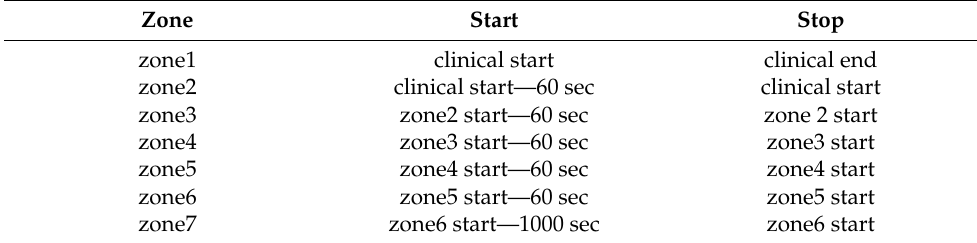
Zone Start Stop zone1 clinical start clinical end zone2 clinical start—60 sec clinical